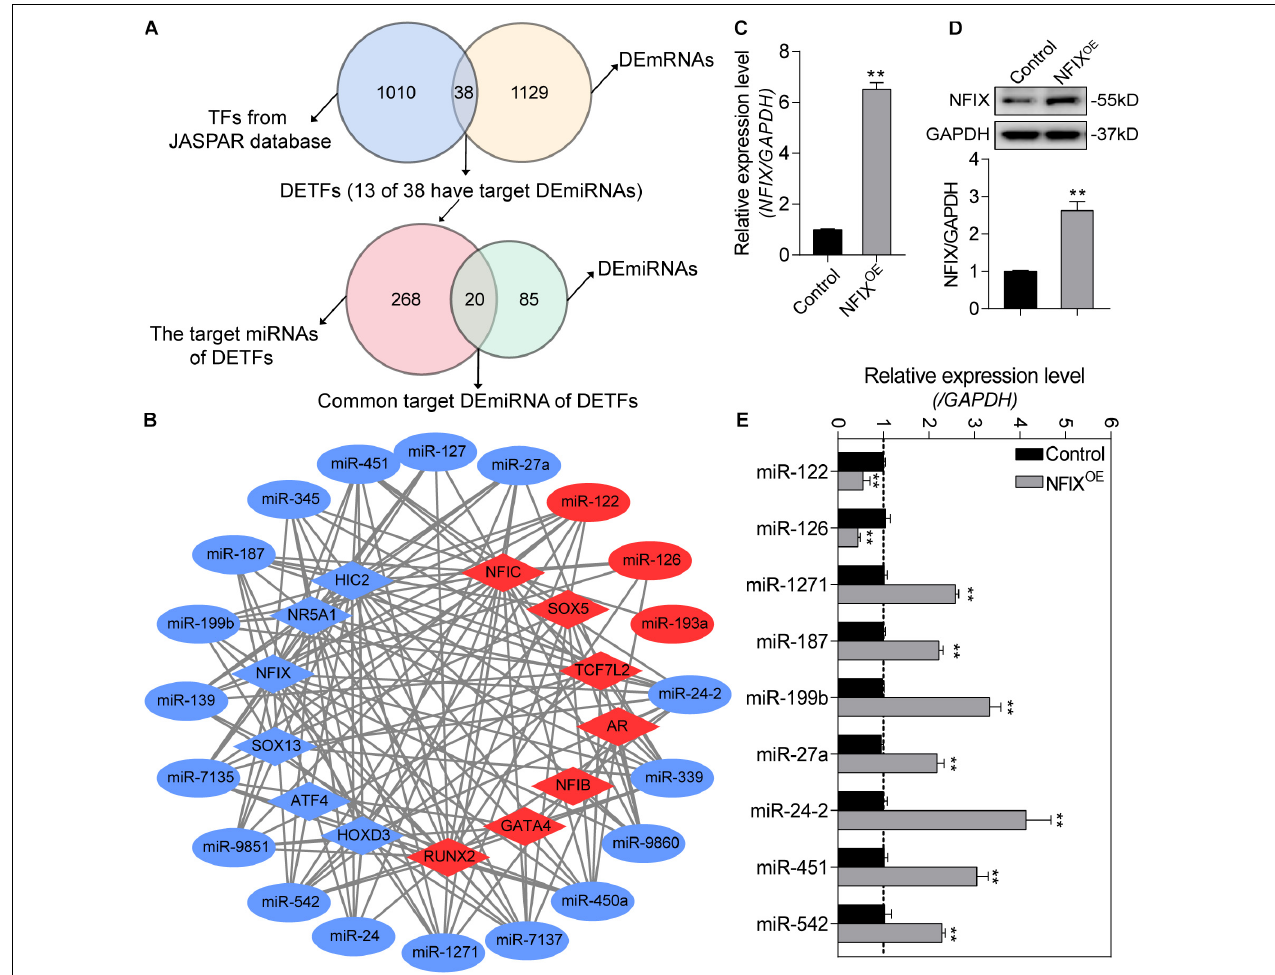
FIGURE 7 | Identification of the potential NORFA -mediated DETF–DEmiRNA regulatory network. (A) Venn diagrams showing the identified DETFs and their target DEmiRNAs. (B) The potential DETF–DEmiRNA regulatory network was constructed. Circles indicate DEmiRNAs and diamonds indicate DETFs. The color depicts the expression patterns (red indicates up-regulated and blue indicates down-regulated). (C,D) The expression of NFIX at both mRNA level (C) and protein level (D) in NFIX overexpressed porcine GCs were detected by qRT-PCR and Western blotting ( n = 3). (E) The expression patterns of the potential NFIX-regulated miRNAs in NFIX overexpressed porcine GCs were identified by qRT-PCR ( n = 3). Data in (C–E) were shown as mean ± S.E.M. with three independent replicates. P values were calculated by a two-tailed Student’s t test. ** P <